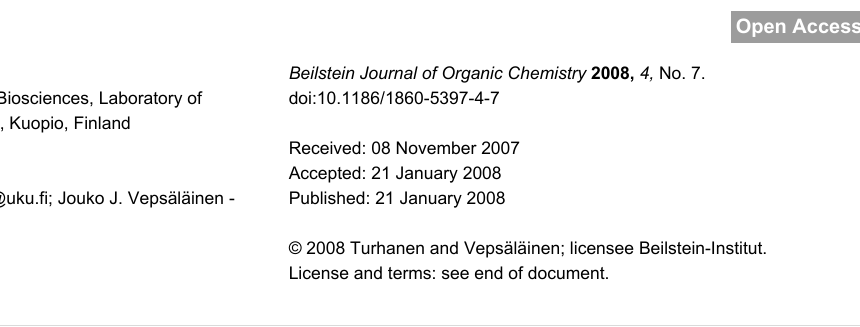
Etidronate, (1-hydroxyethylidene)-1,1-bisphosphonic acid (HEBPA) disodium salt, is one of the earliest synthesized and